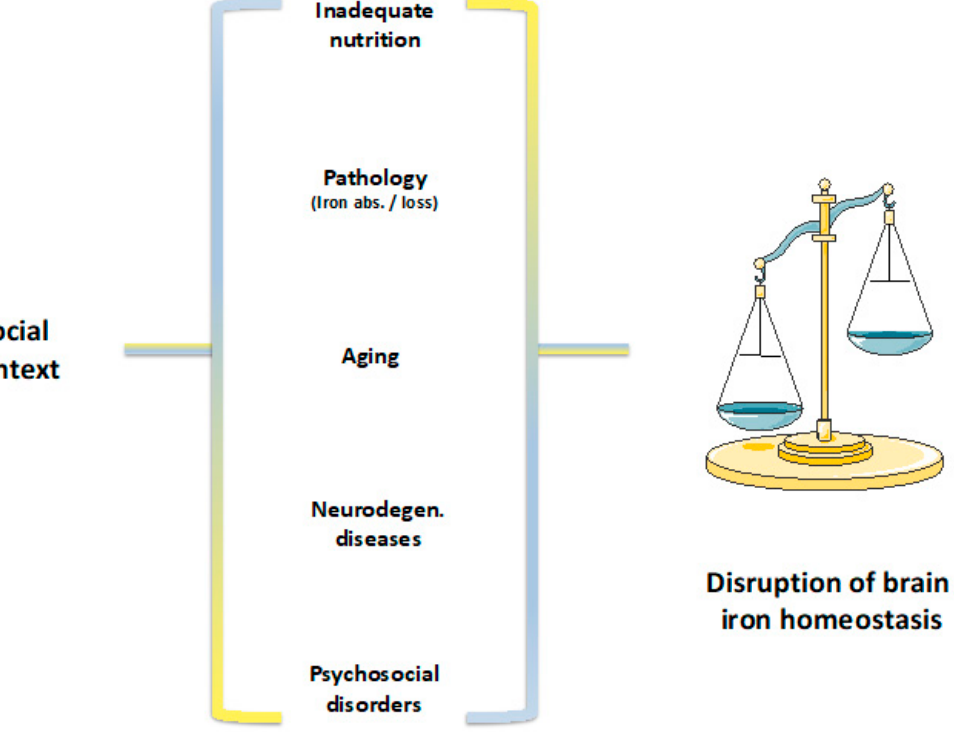
Figure 1. Processes underlying disruption of brain iron homeostasis. Social context, integrating structural (e.g., socio-economic context, life trajectories, socio-economic status, education, knowledge and skills, norms and values), social interactions (e.g., the specific context of interactions; who is present) and individual dimensions (e.g., appraisal, perceptions, motivations and expectations, and reflexivity) frames the pathophysiological mechanisms of an inadequate nutrition (e.g., poor diets, excessive milk intake, vegetarian diets), pathologies associated with inadequate iron absorption (e.g., Celiac disease) or excessive iron loss (e.g., blood loss, parasitic infections), aging, neurodegenerative diseases (e.g., Alzheimer’s and Parkinson’s disease) or psychosocial disorders (e.g., chronic social defeat stress, anxiety, depression). All these conditions are associated with a disruption of brain iron